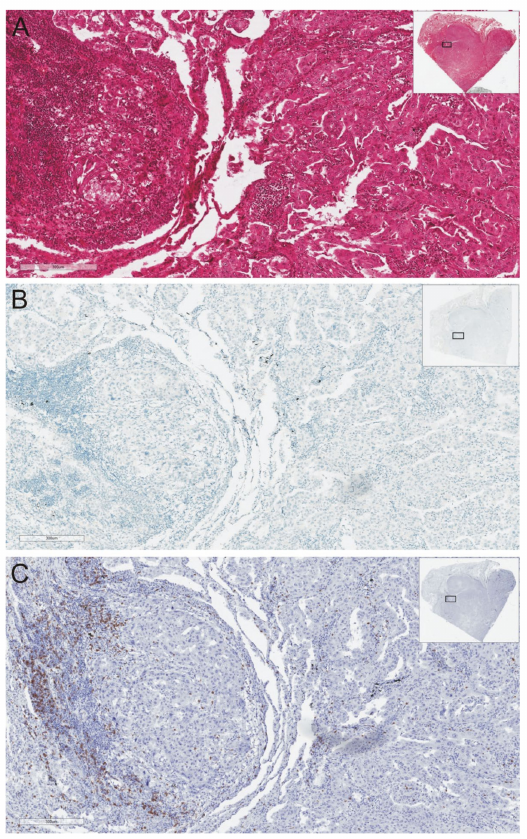
Figure 4. A case illustration of lung adenocarcinoma tissue in which the cells of the immune system marginally infiltrate the neoplastic tissue without PD-L1 expression: ( A ). hematoxylin/eosine staining; ( B ). PD-L1 expression; ( C ). CD8 expression. Immunohistochemical staining was performed on authors’ own